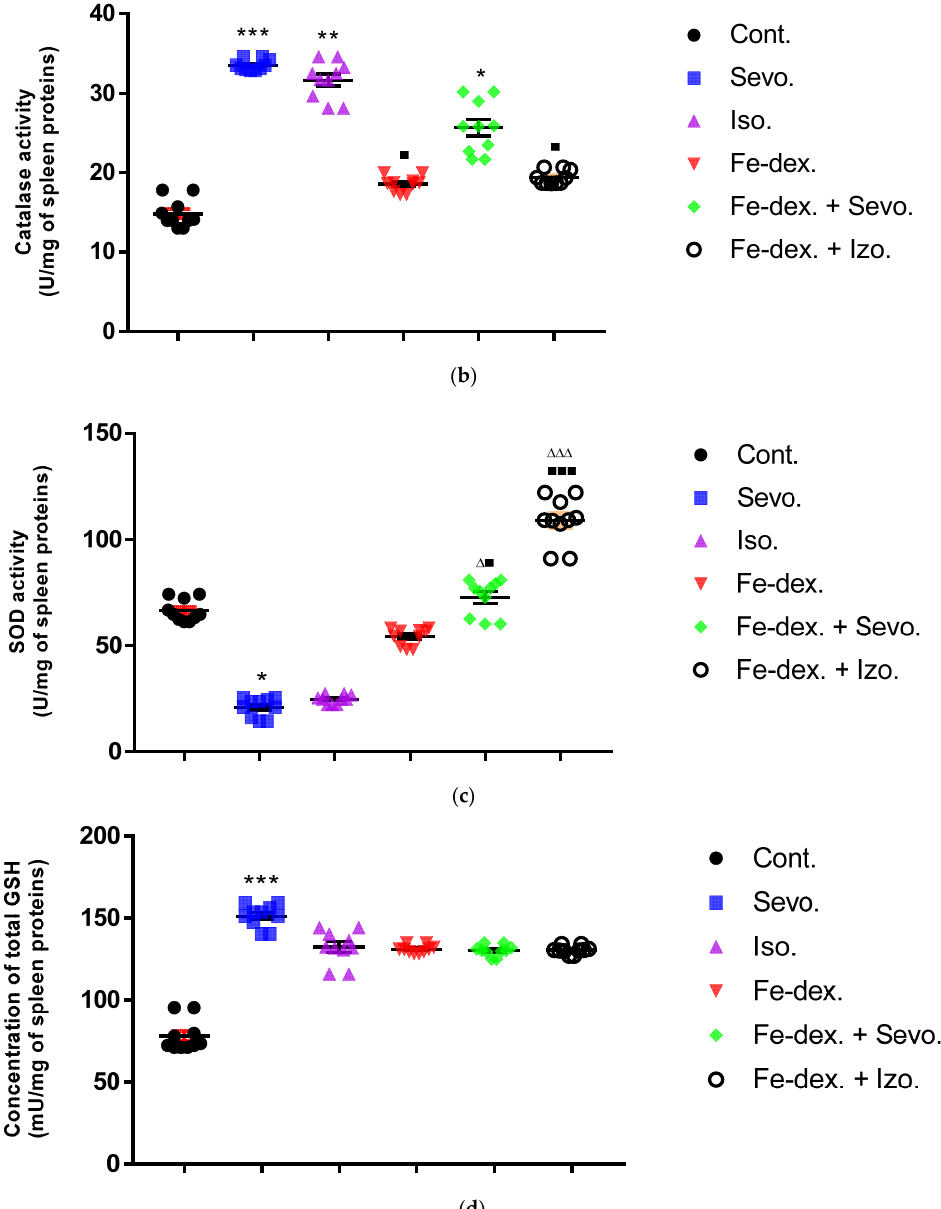
Figure 11. Effect of inhaled anesthetics and iron dextran on MDA ( a ), CAT activity ( b ), SOD activity ( c ), and GSH ( d ) in the spleen of rats treated for 28 days. Rats ( n = 10 per group) were treated with ip injection of iron dextran (50 mg/kg), exposed to 2.4 vol % sevoflurane inhalation and 1.3 vol % isoflurane inhalation, and exposed to a combination thereof where inhaled anesthetics were given 2 h after ip injection of iron dextran. Animals were treated every other day for 28 days. Each animal sample is indicated by a single dot. The results are expressed as the mean value of each experimental group ± SE. * Statistically significant compared to the control group (* p < 0.05; ** p < 0.01; *** p < 0.001); ■ Statistically significant compared to the sevoflurane group ( ■ p < 0.05; ■■■ p < 0.001); ∆ Statis- tically significant compared to the isoflurane group ( ∆ p < 0.05; ∆∆∆ p < 0.001). Other statistically sig- nificant changes exist in: ( c ) SOD activity (U/mg of spleen proteins)—Fe-dex. vs. Fe-dex. + Iso. ( p < 0.05). Abbreviations : Cont., control group; Sevo., sevoflurane group; Iso., isoflurane group; Fe-dex., iron dextran group; Fe-dex. + Sevo., group treated with iron dextran and sevoflurane; and Fe-dex. + Iso., group treated with iron dextran and isoflurane.